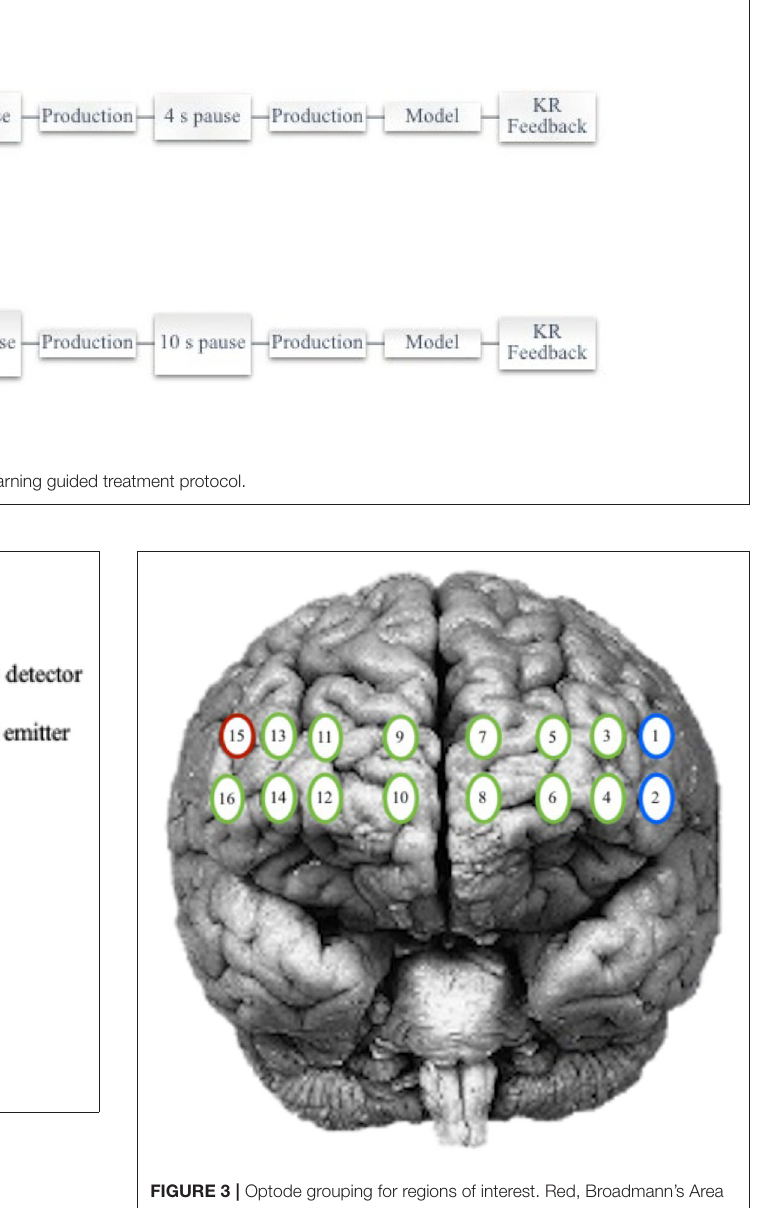
includes information about location, day, participant, and